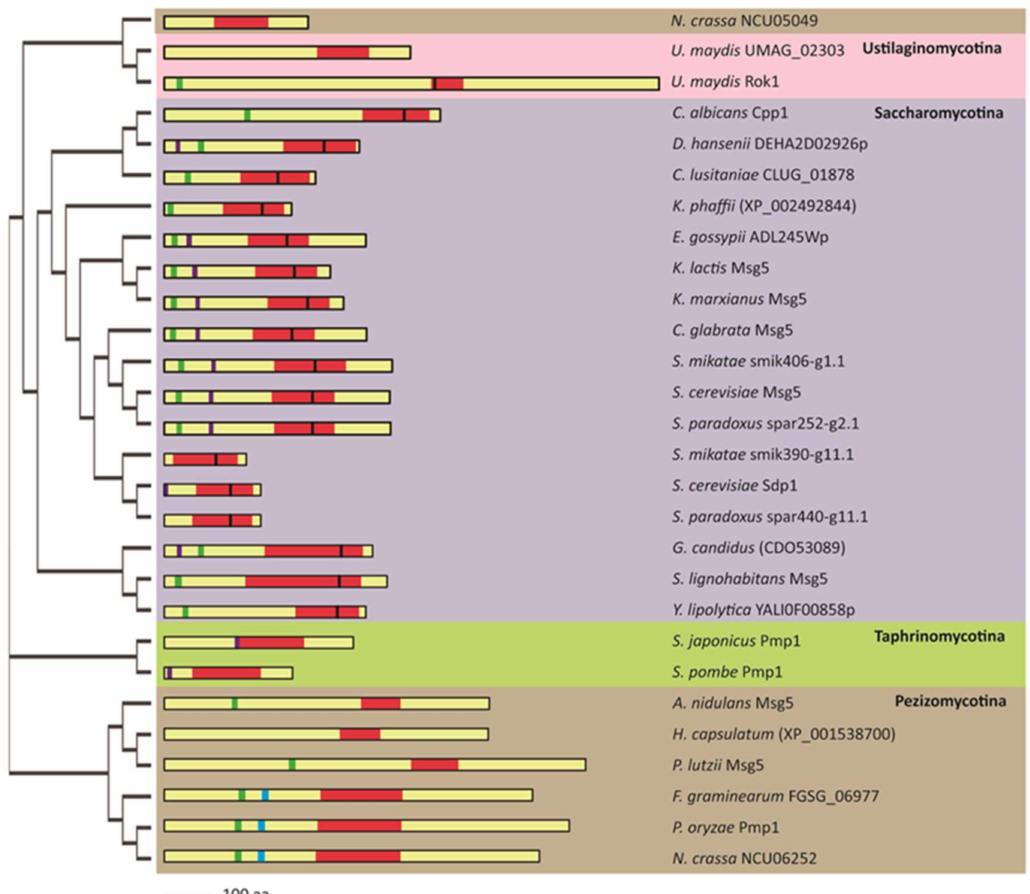
Figure 3. Phylogram and scaled scheme of the domain composition and taxonomic classification of the ScMsg5 orthologues from different fungal species. The phylogram was obtained by multiple protein sequence alignment, using Clustal Omega program (European Bioinformatics Institute (EMBL-EBI), Hinxton, UK) at default settings, of ScMsg5 orthologues selected from National Center for Biotechnology Information (NCBI), Kyoto Encyclopedia of Genes and Genomes (KEGG), or fungal genome databases [ Saccharomyces Genome Database (SGD), S. pombe database (PomBase), Candida Genome Database (CGD), and Aspergillus Genome Database (AspGD)]. Proteins included are Neurospora crassa NCU05049 (XP_956423), Ustilago maydis UMAG_02303 (XP_011388628), Ustilago